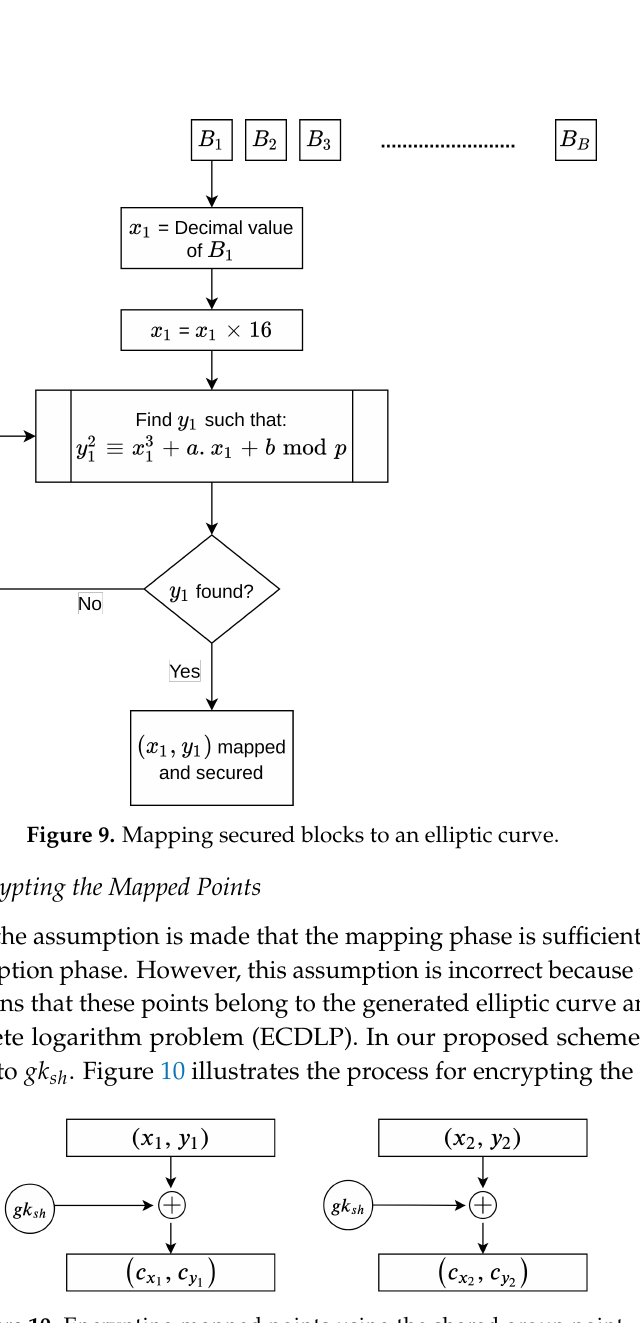
Figure 10. Encrypting mapped points using the shared group point.